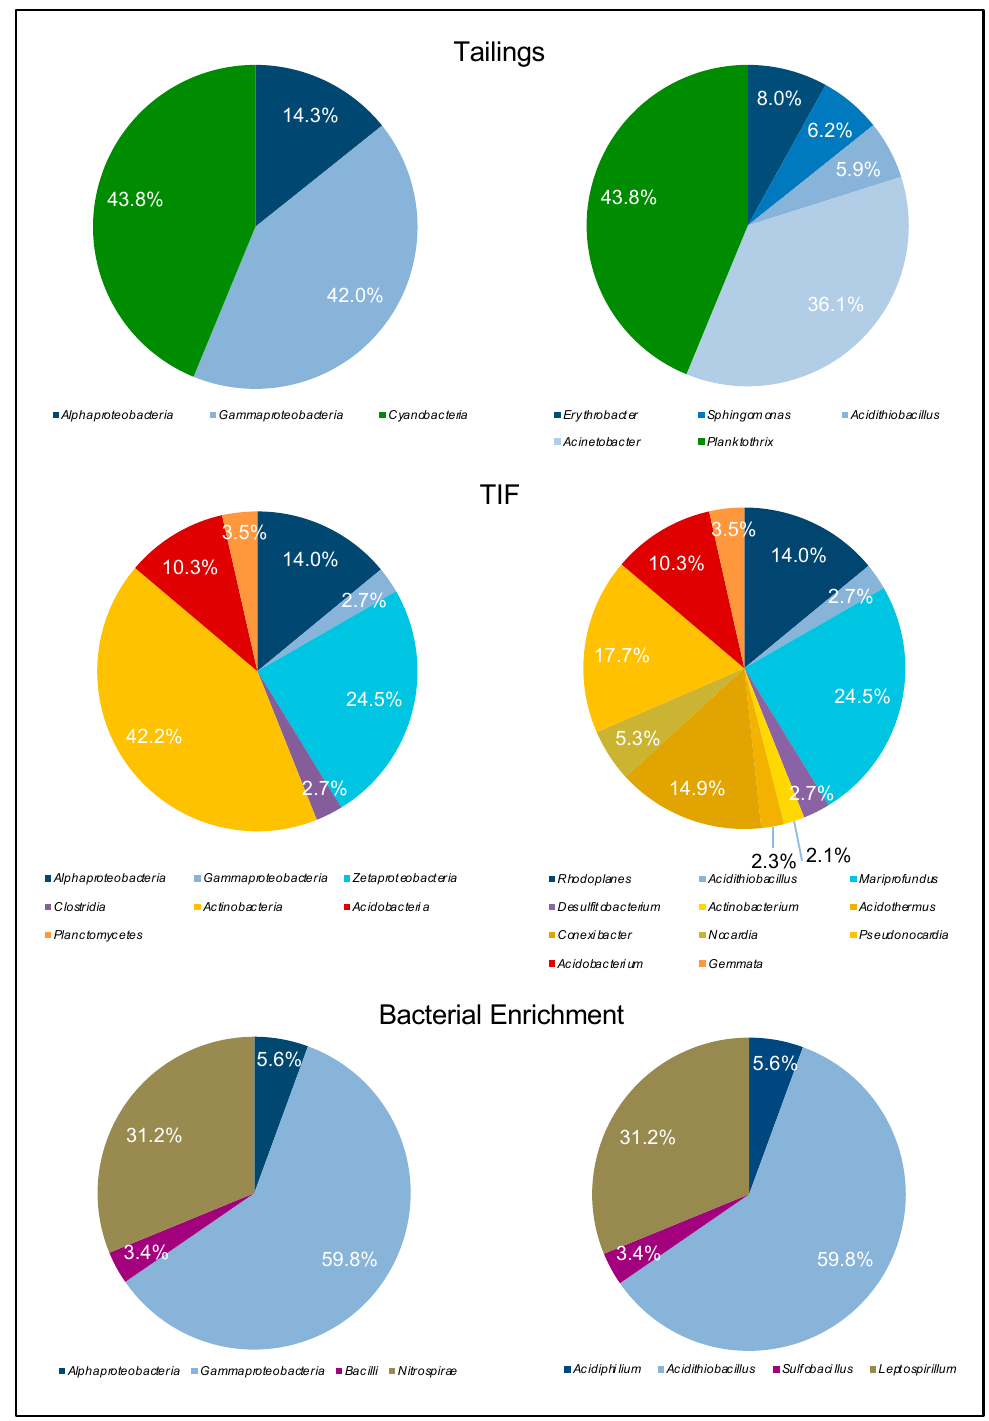
Figure 4. Pie charts of the relative OTU abundances at the phylum level ( left ) and genus level ( right ) from the tailings, TIFs, and bacterial enrichment samples.